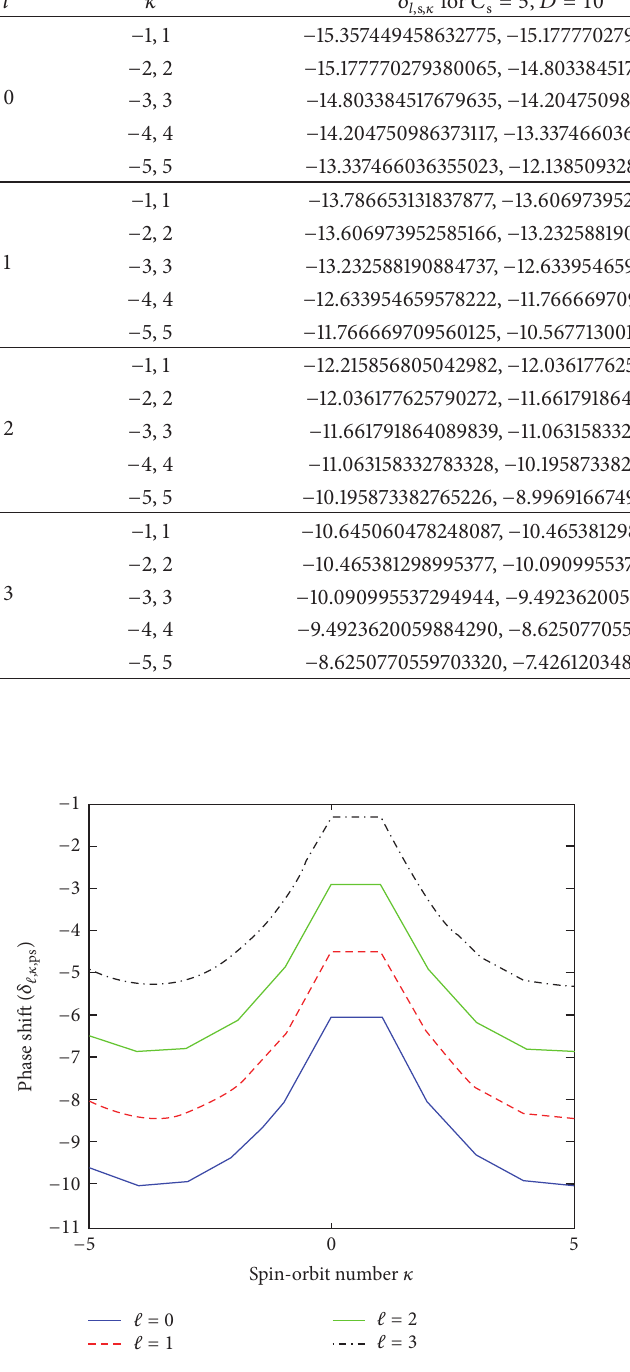
Figure 2: A plot of pseudospin scattering phase shifts for the Figure 3: A plot of spin scattering phase shifts for the hyperbolical hyperbolical potential as a function of spin-orbit number 𝜅 for 𝑙 = potential as a function of spin-orbit number 𝜅 for 𝑙 = 0, 1, 2,3 with = 0.10 , 𝛼 = 0.10 , 0, 1,2, 3 with positive potential parameter 𝜎 positive potential parameter 𝜎 0 = 0.50 , 𝛼 = 0.50 , 𝑐 𝑜 = 1/12 , 𝐶 s = 5 , 0 = 1/12 , 𝐶 = 0.05 , 𝐷 = 10 , and 𝐸 = 𝑀 = 1 . The relativistic 𝑐 𝐷 = 10 , and 𝐸 = 𝑀 = 1 . The relativistic mass and energy are equal 𝑜 ps mass and energy are equal in all the calculations. in all the